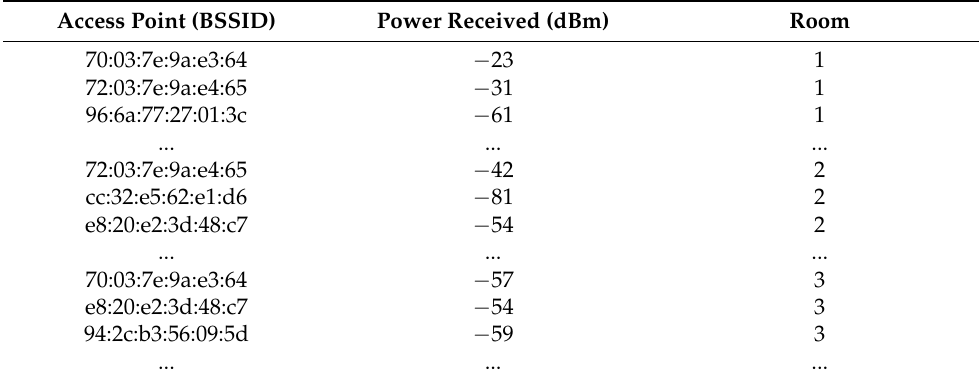
Table 2. Samples of data collected by Andruino-R2 moving in a three-room layout. Access Point